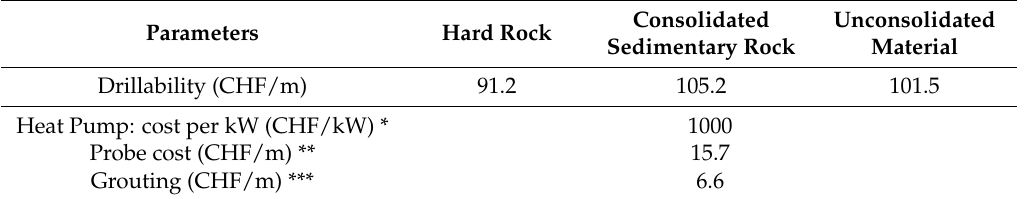
Table 9. Economic parameters for the costs estimate: the drilling technique used for consolidated sedimentary rocks and unconsolidated material was direct flush mud rotary while the drilling technique used within hard rock is down the